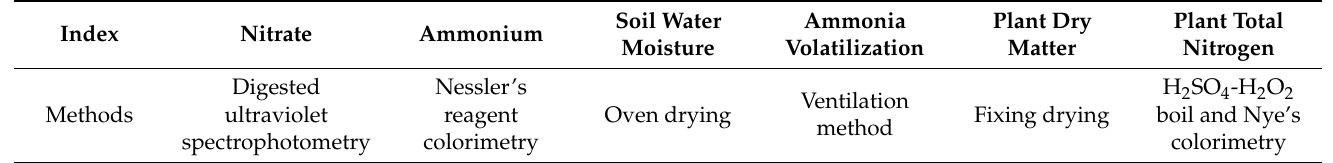
Table 4. Chemical